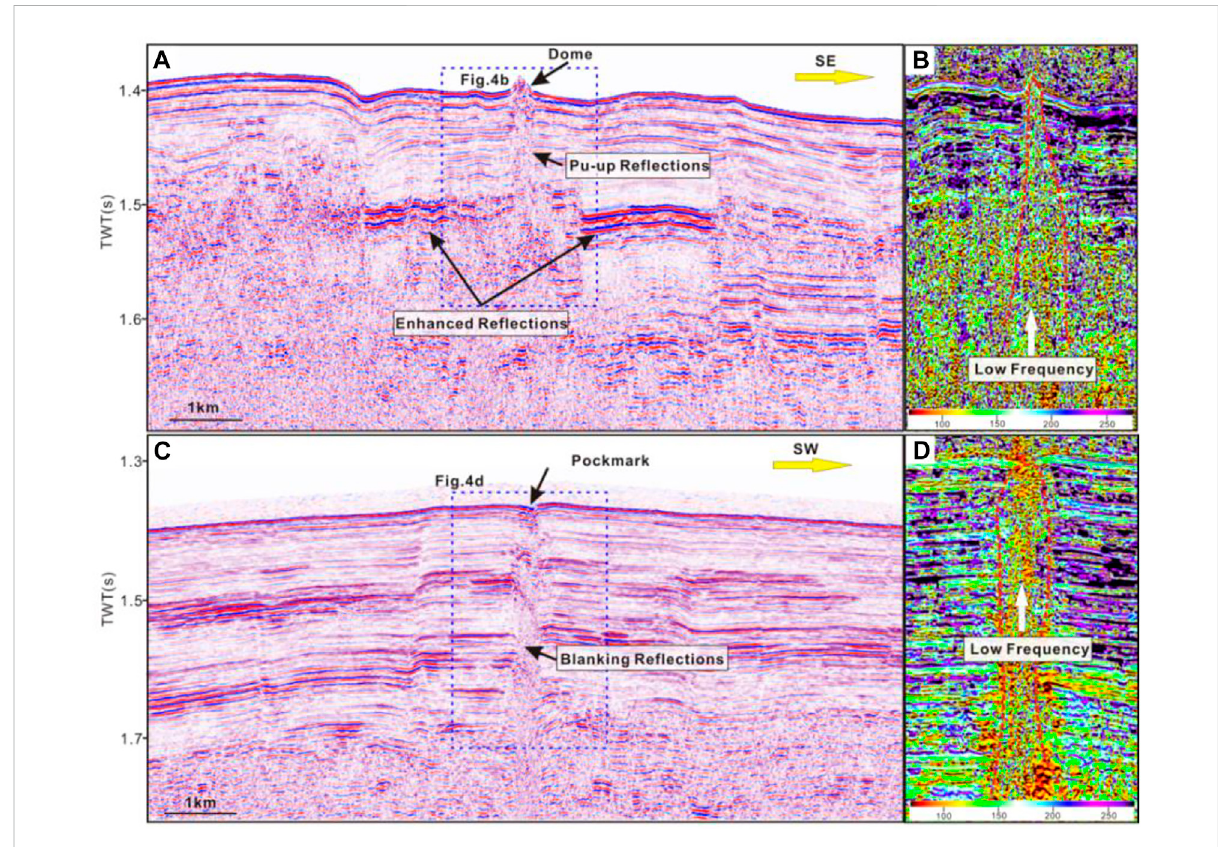
FIGURE 4 Type-Aseismicchimneys. (A,C) Seismicpro fi les.Adomeorpockmarkisobservedabovechimneys; (B,D) Theinstantaneousfrequencyattribute pro fi les, which locations are shown in Figure 4A. Low-frequency anomalies are observed within the chimneys. See locations in Figure